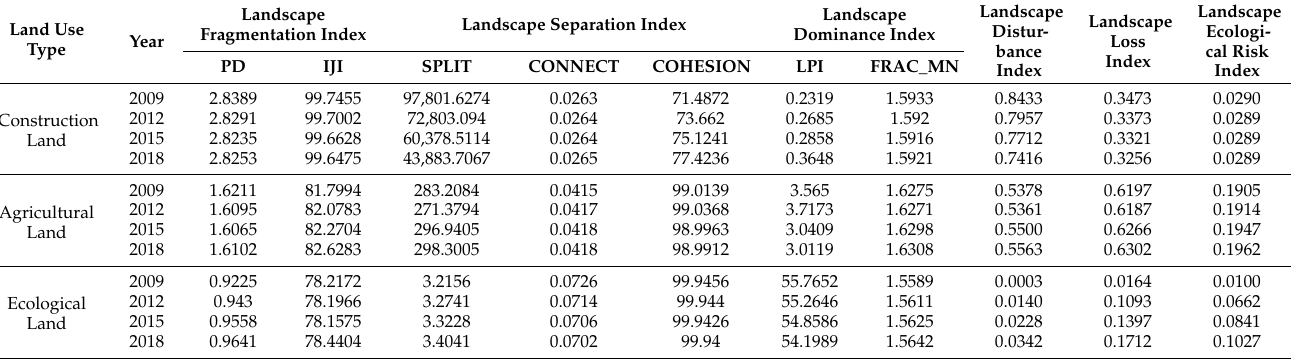
Table 8. Characteristics of Landscape Ecological Risk Index in Changde from 2009 to